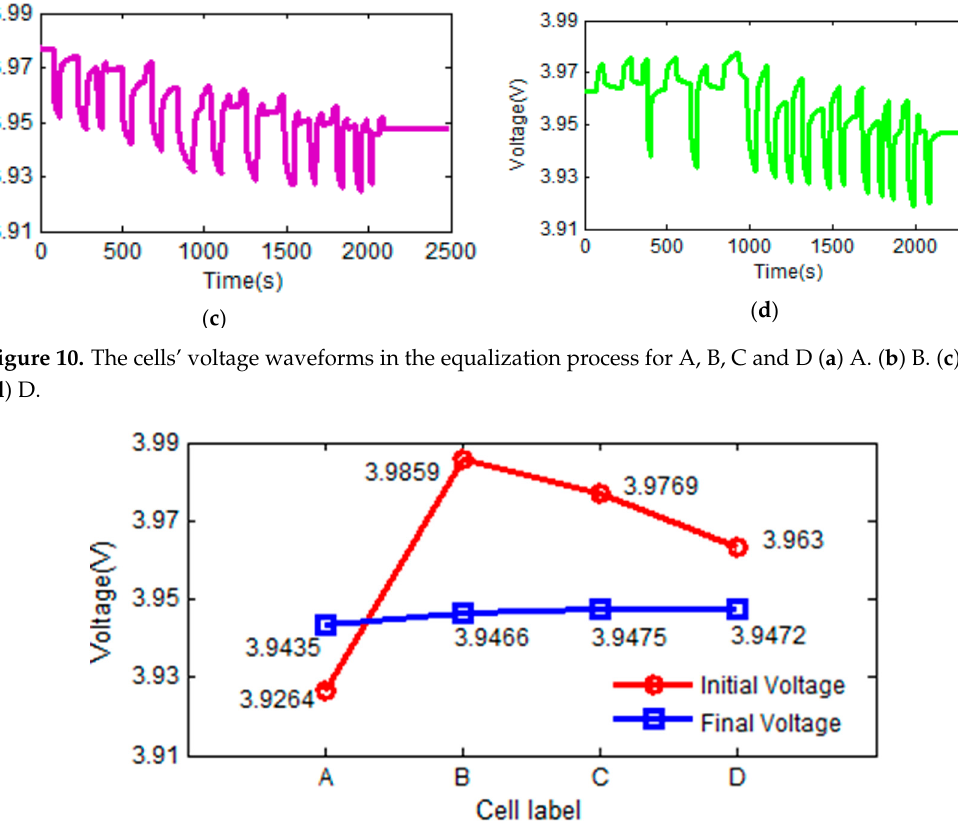
Figure 11. Voltages of the four cells before and after equalization.